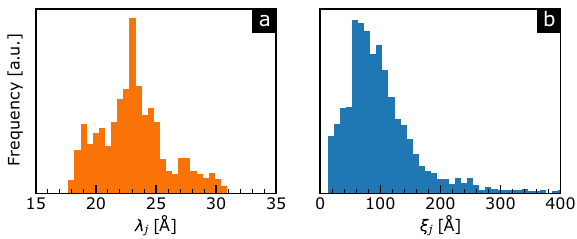
Fig. 9 Fitting parameters for model supercurrent. Analysis of the ð w Þ for individual k fi tting parameters of j fit ∥ , shown in Fig. 3a by 1 semitransparent green lines. Distribution of a half-periods, λ j , and b decay lengths, ξ j